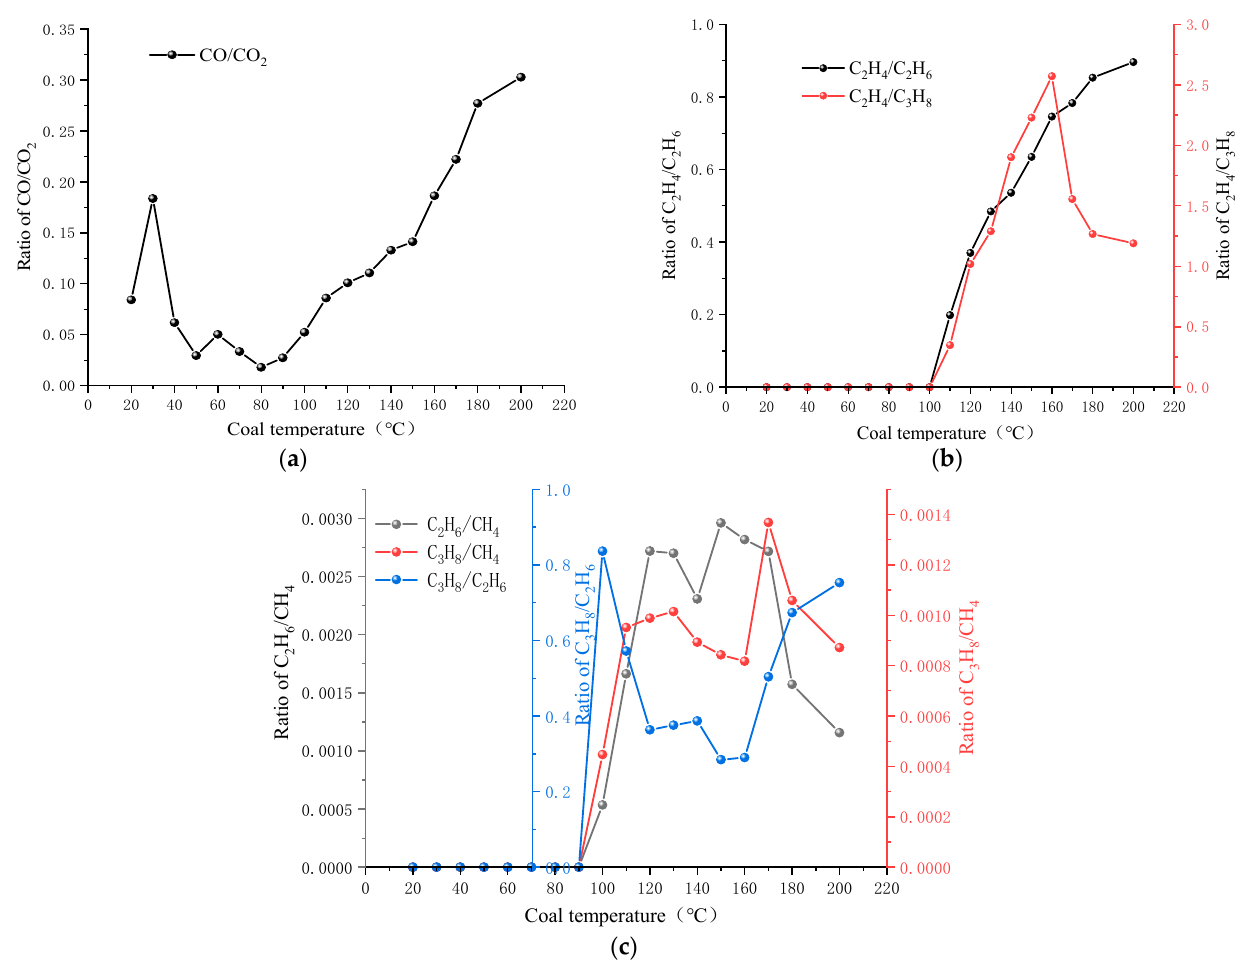
Figure 10. Distribution of different gas ratios against the coal seam. ( a ) CO/CO 2 ratio, ( b ) alkene ratio, ( c ) alkane ratio.